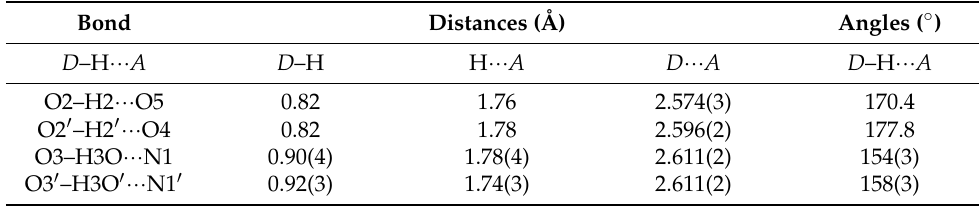
Table 2. Hydrogen bonding geometry parameters for H 4 L.